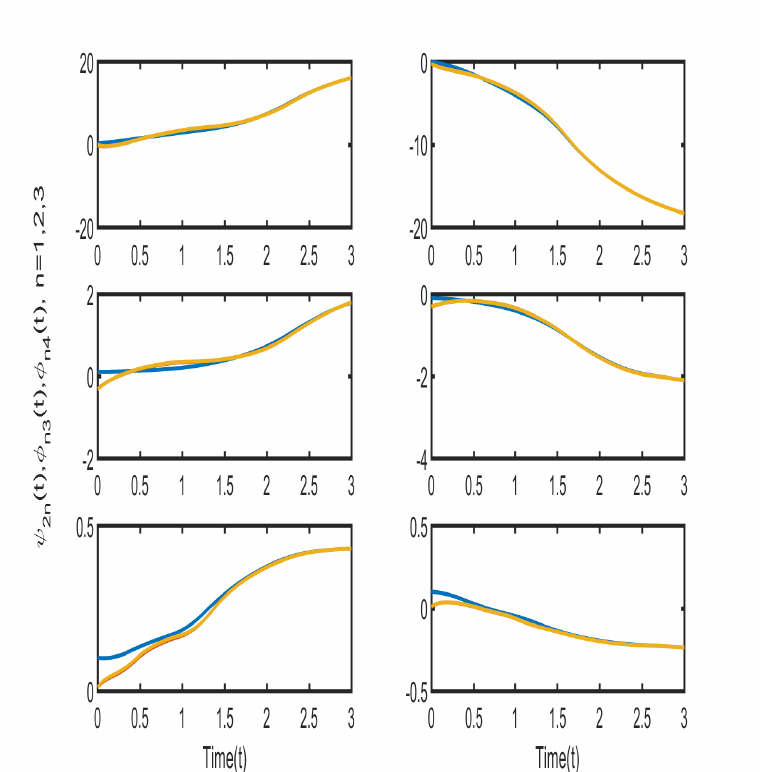
Figure 7. The real and imaginary parts of state trajectories of cluster two i.e., ( h = 2, i = 3,4 ) of CVNNs (23) and